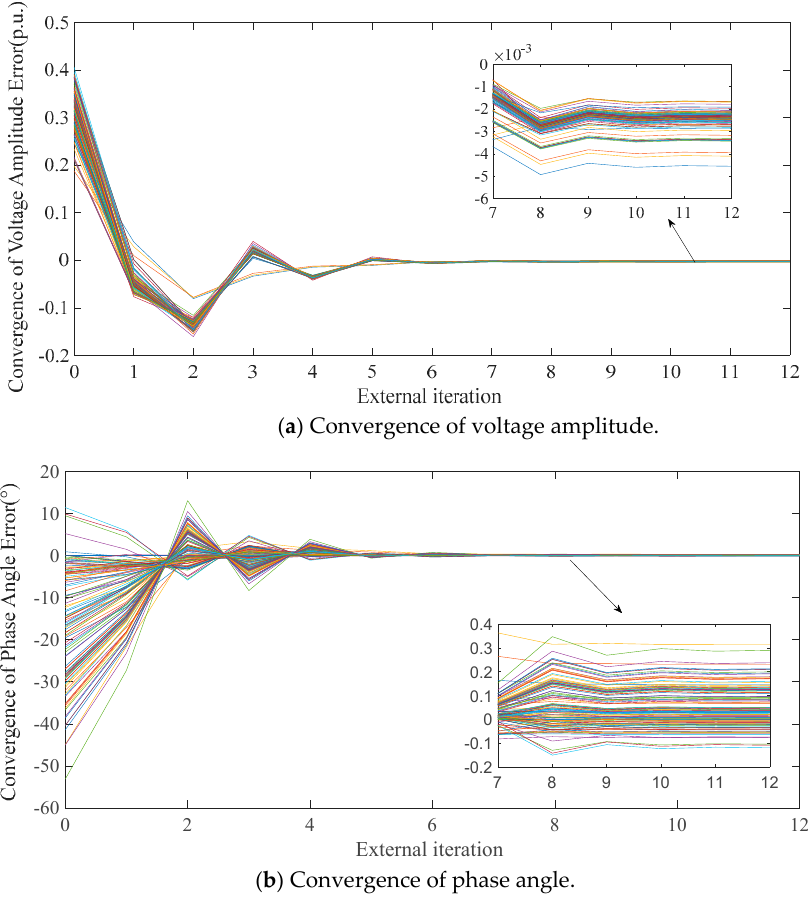
Figure 8. Convergence performance of proposed distributed method benchmarked with conventional centralized state estimation method for the IEEE 118-bus system.